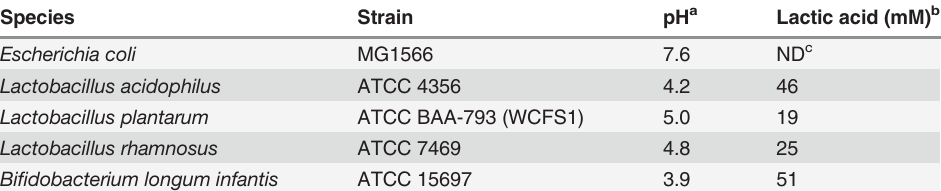
Corresponding fi nal pH of culture media and lactic acid concentration after 24 h growth at 2% O 2 in LMRS are indicated. a pH of LMRS media after 24 h of bacterial growth. All are ± 0.1 (initial pH = 6.5) b Values are ± 1 mM and each sample was assayed in triplicates.